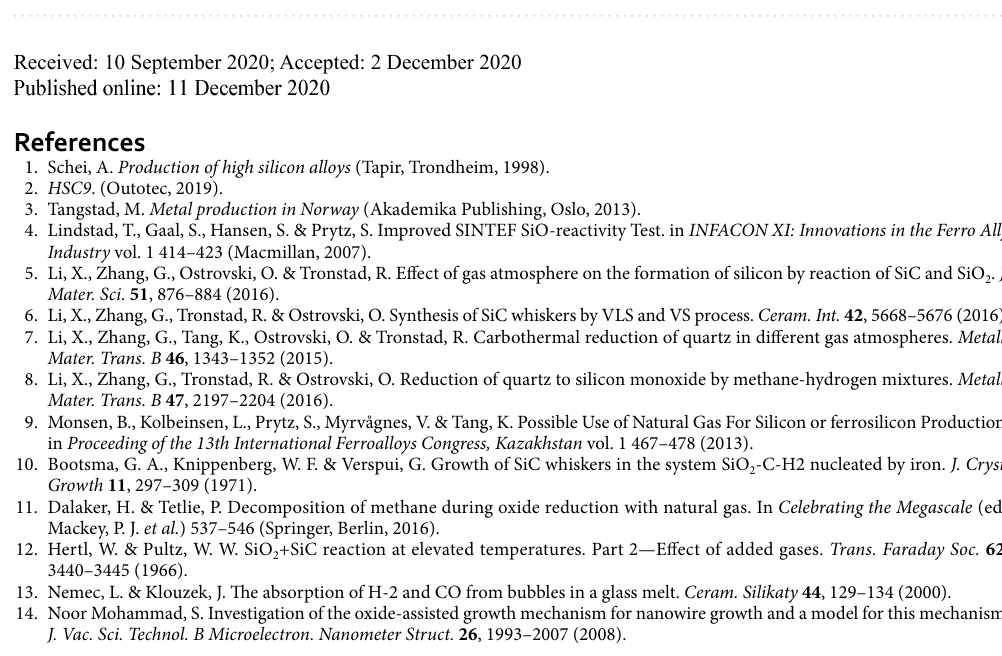
Figure 15. The SiC formed at 1750 °C using 5% CH 4 in H 2 as the process gas. (a) is from the top of the crucible, (b) is from around the middle and (c) is from close to the bottom. (d) is SiC formed on the alumina lance with the same structure as (a) and (b)